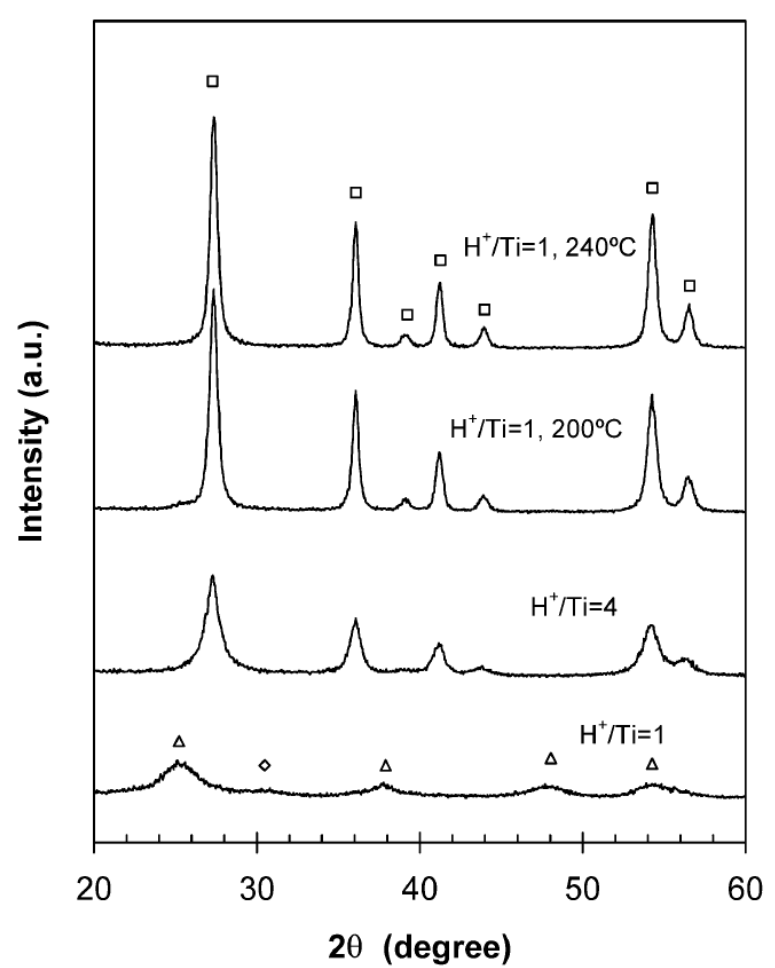
Figure 10. Evolution of the XRD pattern of a TiO 2 sample peptized with HNO 3 and hydrothermally treated at different temperatures, from [90]. ( Δ ) anatase, ( ◊ ), brookite, and ( □ ) rutile phases (repro- duced with permission from J. Yang et al., Journal of Colloid and Interface Science; published by Elsevier, 2005).